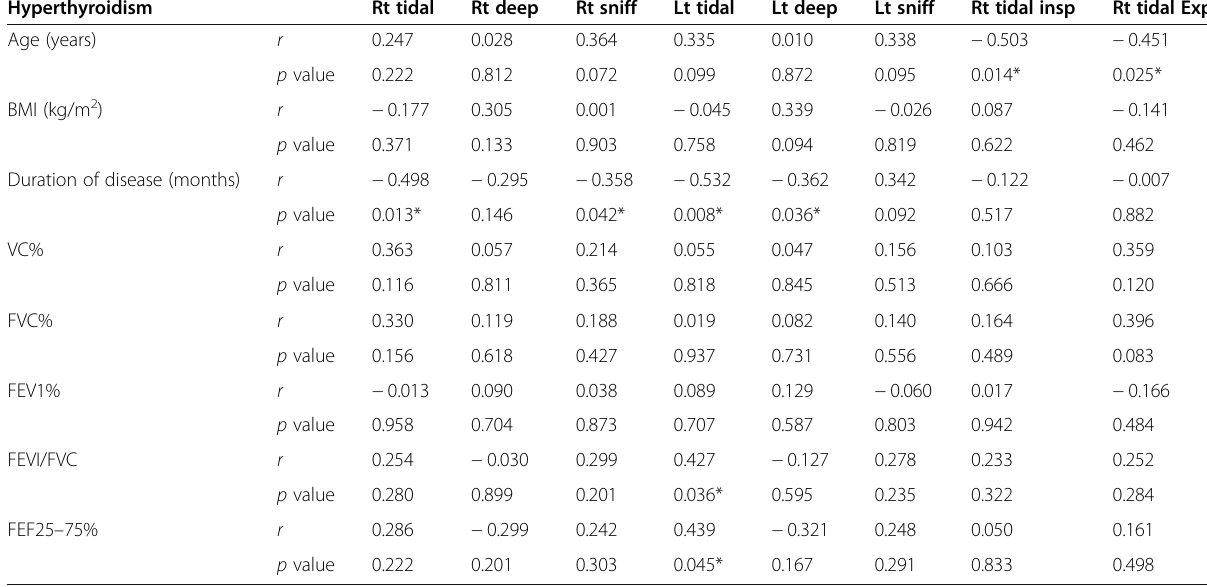
Table 4 Correlation between diaphragmatic excursion and diaphragmatic thickness with demographic data, duration of disease, and pulmonary function test in hyperthyroidism group Hyperthyroidism